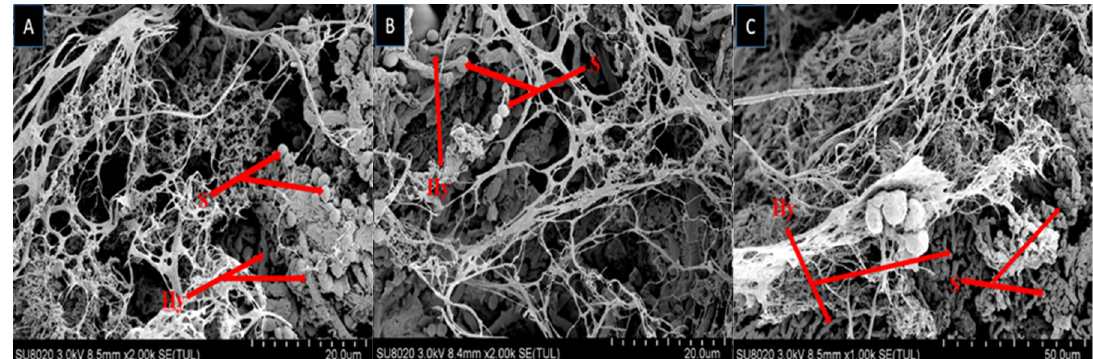
Figure 3. Scanning electron micrograph of infected larva reveals spores and hyphae structures in body cavity; B. bassiana OFDH1-5 ( A ); T. asperellum GDFS1009 ( B ) and B. bassiana OFDH1-5+ T. asperellum GDFS1009 ( C ). Arrow indicates spores (S) and hyphae (Hy).